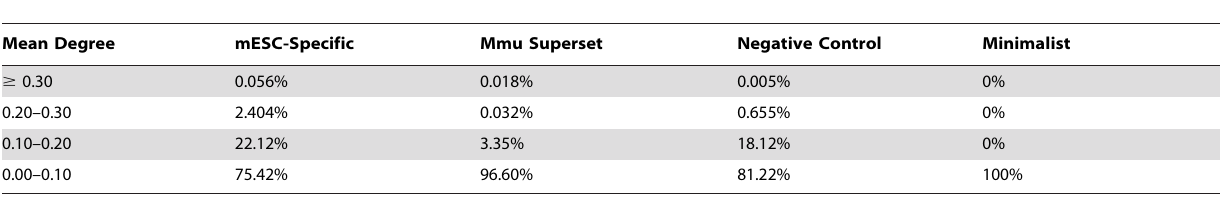
Table 3. Comparison mESC-Specific and Test Network